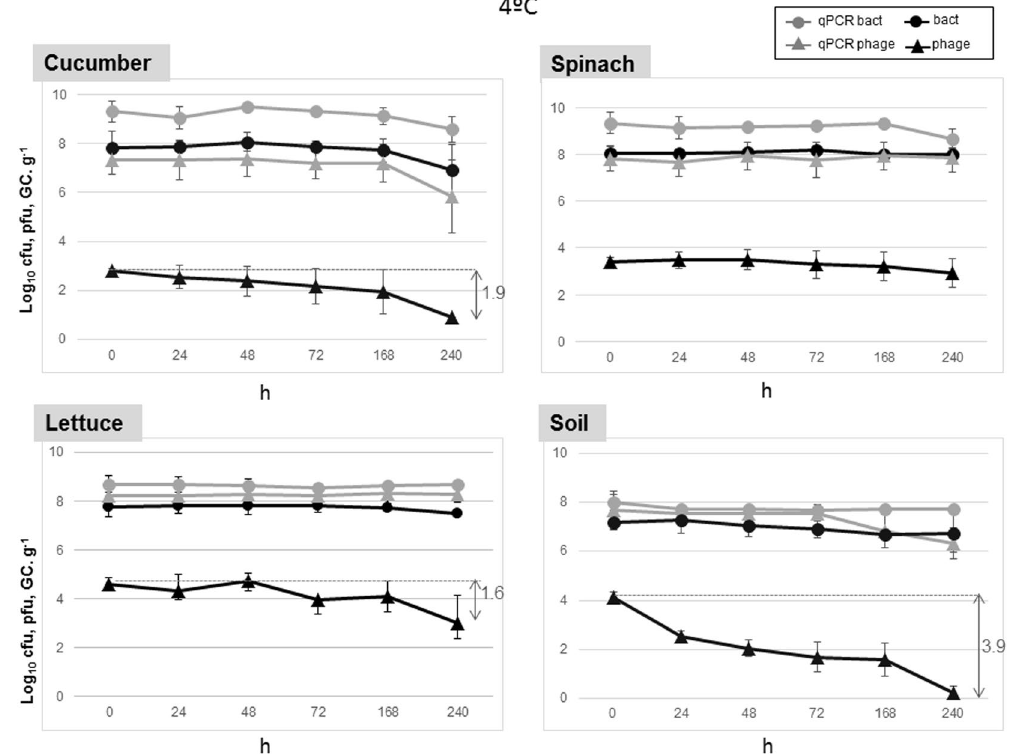
Figure 2. Stability of 933W and E . coli C600 (933W ∆ stx :: gfp - cat ) after 10 days of storage at 4 °C in the different matrices (cucumber, spinach, lettuce, and soil). Values for culturable bacteria are expressed in log 10 cfu. g − 1 . Infectious phages were evaluated by plaque blot and values expressed as log 10 pfu g − 1 . Phage and bacterial genomes were evaluated by qPCR with the stx qPCR assay and the gfp qPCR assay, respectively, and the results are expressed as log 10 GC.g − 1 . All results are the mean of three independent experiments. Those microorganisms showing significant ( P < 0.05) reductions are indicated by a vertical